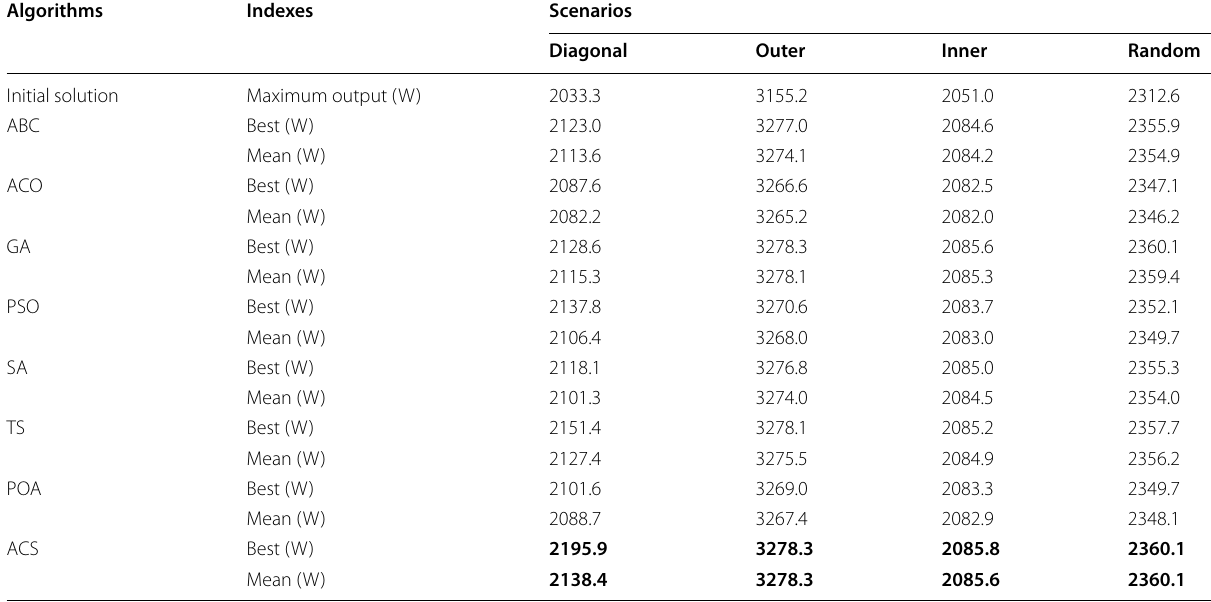
Table 4 Statistical results obtained by each algorithm in four different scenarios of a (20